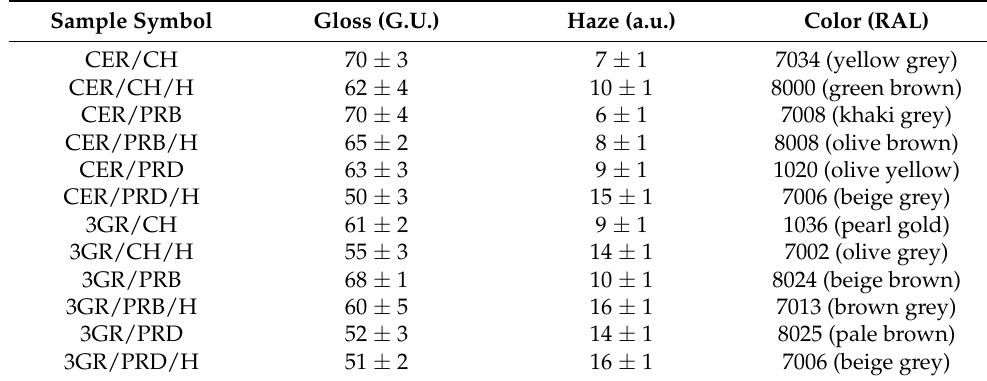
Table 3. Visual properties of prepared coatings and reference samples. Sample Symbol Gloss